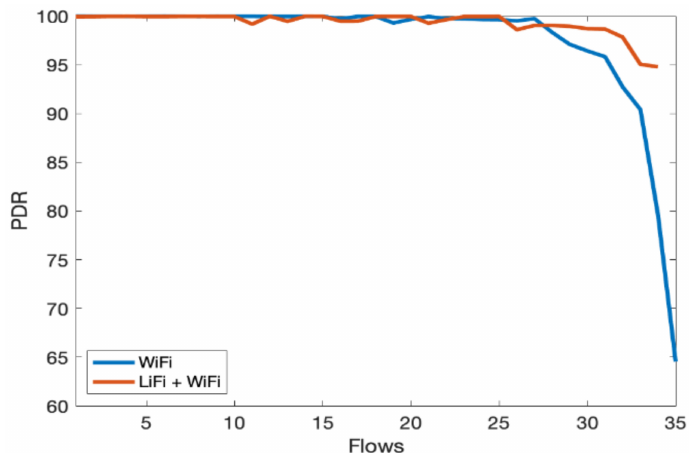
Figure 11. Packet drop ratio (PDR) vs. number of